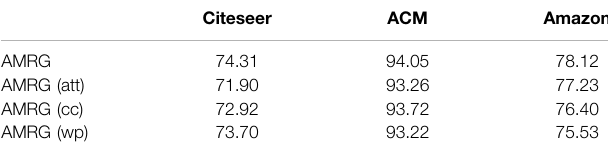
TABLE 6 | Node classi fi cation accuracy ( % ) (Bold: Best; underline: Runner-up). Citeseer ACM